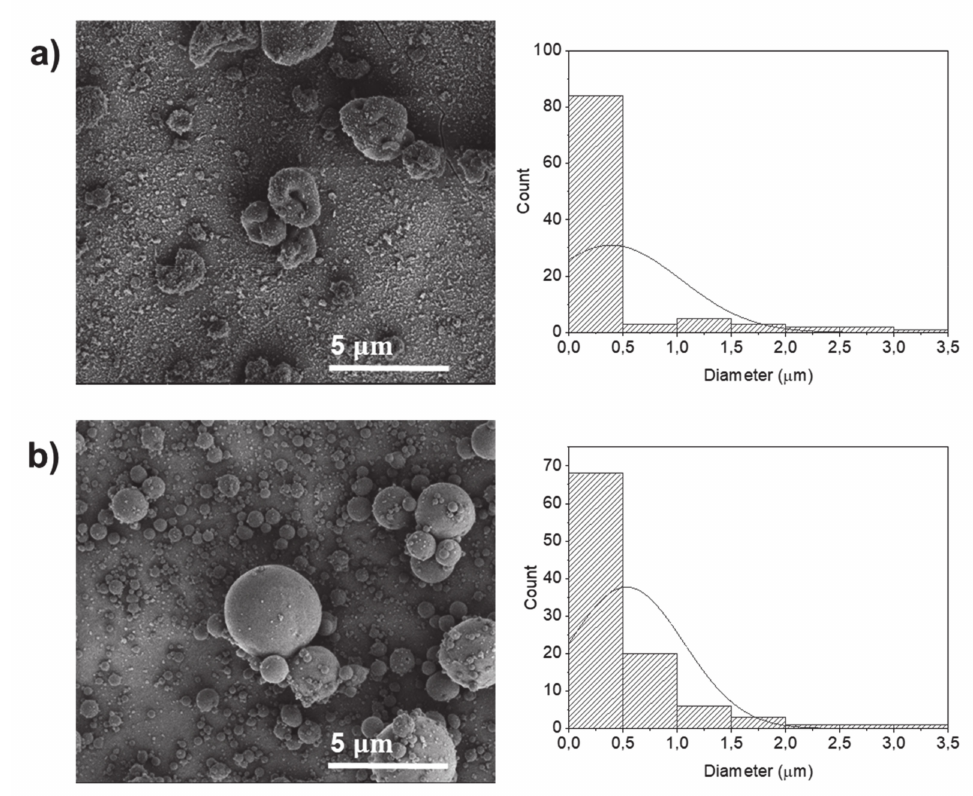
Figure 3. SEM images of electrosprayed potato protein particles and respective histograms displaying their diameter distribution. Samples prepared using water:ethanol (9:1) as a solvent and potato protein concentrations of ( a ) 10% w / v and ( b ) 20% w / v